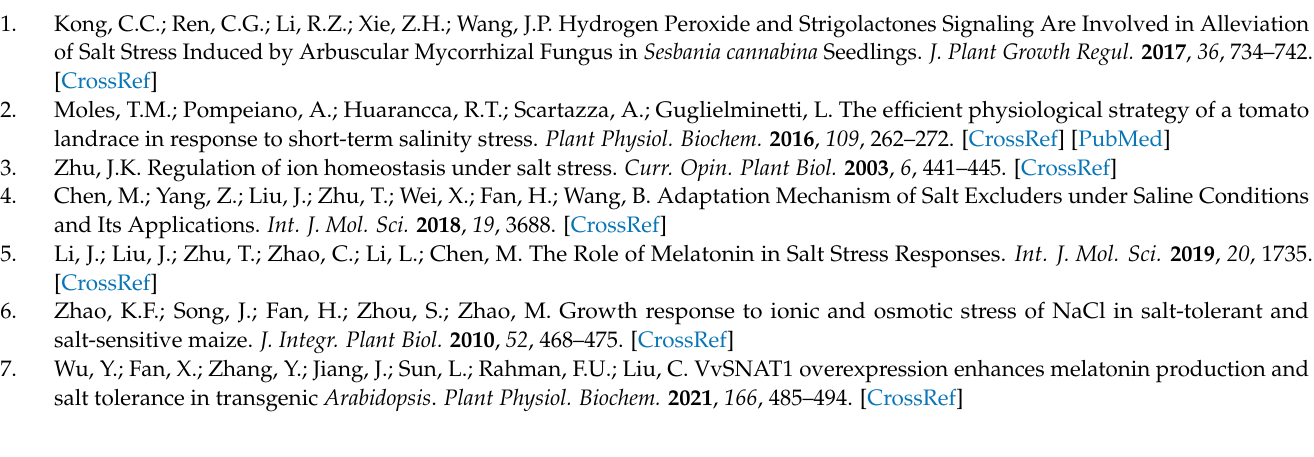
transgenic plants; Table S1: Primer sequences used in this study; Table S2: Rosette leaf number and shape of Arabidopsis